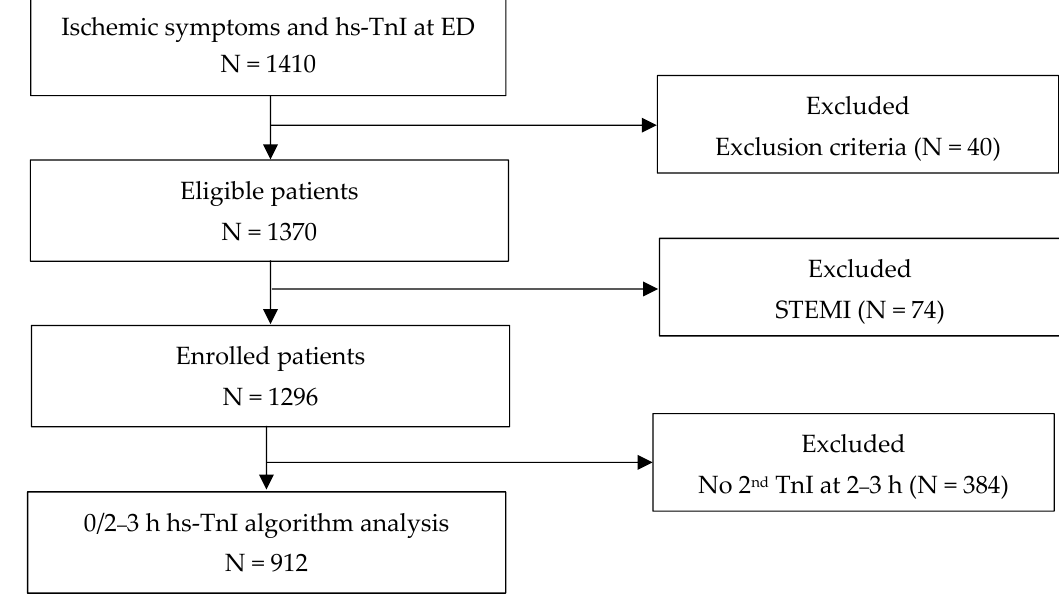
Figure 1. Patient enrollment process. Table 1. Baseline characteristics and Access hs-TnI levels of 1296 patients with ischemic symptoms.